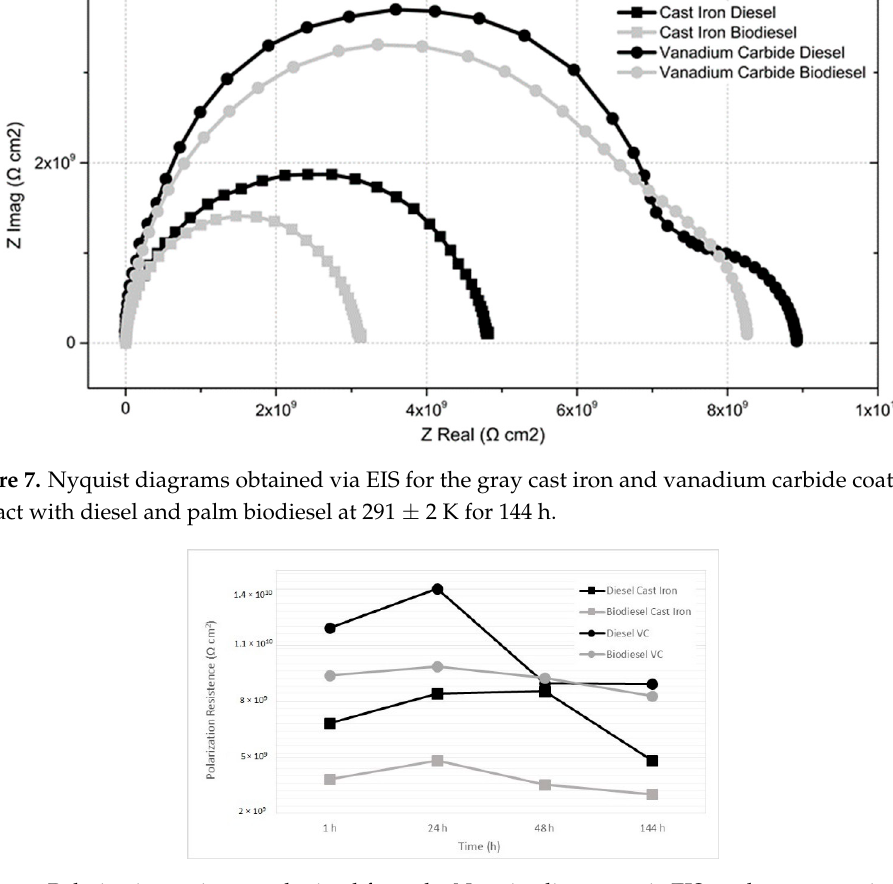
Figure 8. Polarization resistance obtained from the Nyquist diagrams via EIS on the gray cast iron and VC coating for 1, 24, 48, and 144 h, at 291 ± 2 K.